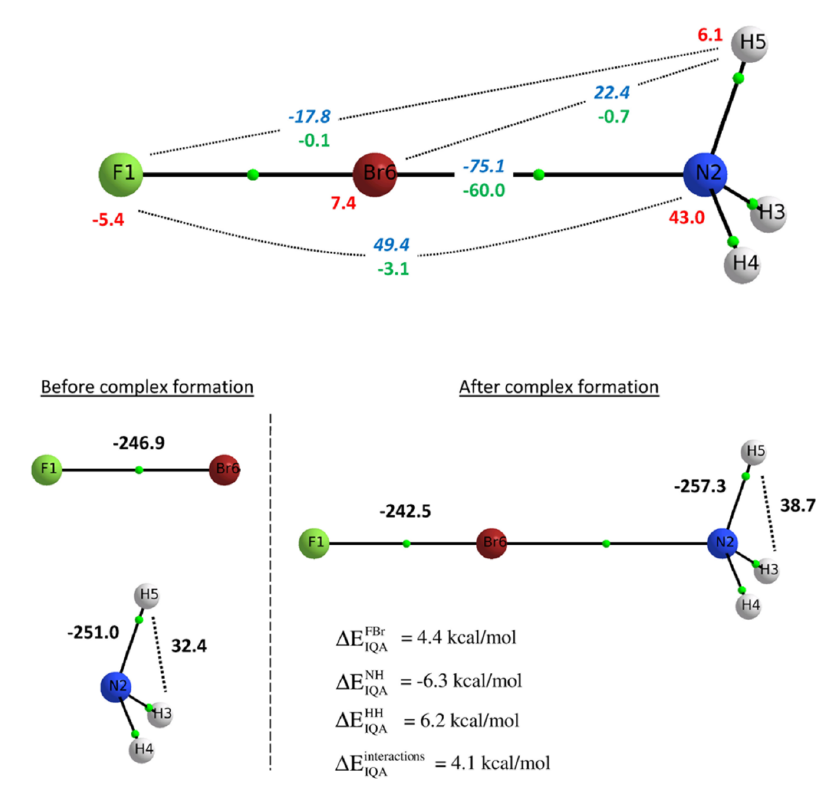
Figure 4. IQA energy partition of the FB r · · · NH 3 complex. ( Top ) changes intra-atomic energies (red) and intermolecular interactions (classical and exchange terms in blue and green, respectively). ( Bottom ) Change in interatomic energies within each fragment upon complex formation. Figure reprinted (adapted) with permission from reference [98]. Copyright 2020 American Chemical